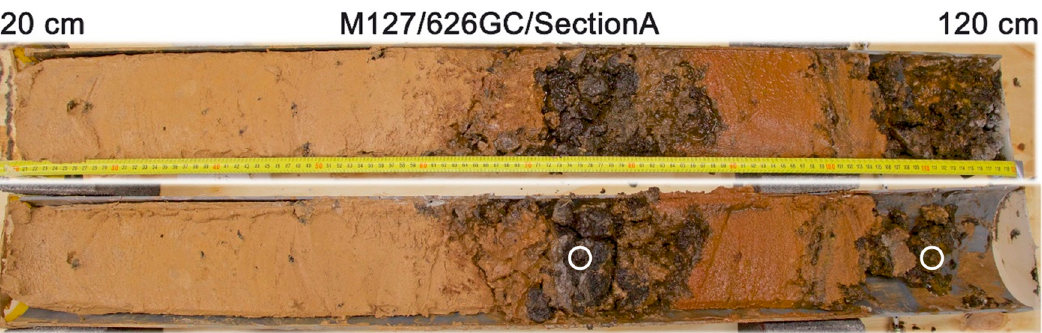
Figure 9. Image of sediment core GC-626 with sampling points in coarse-grained manganiferous core sections (white circles).